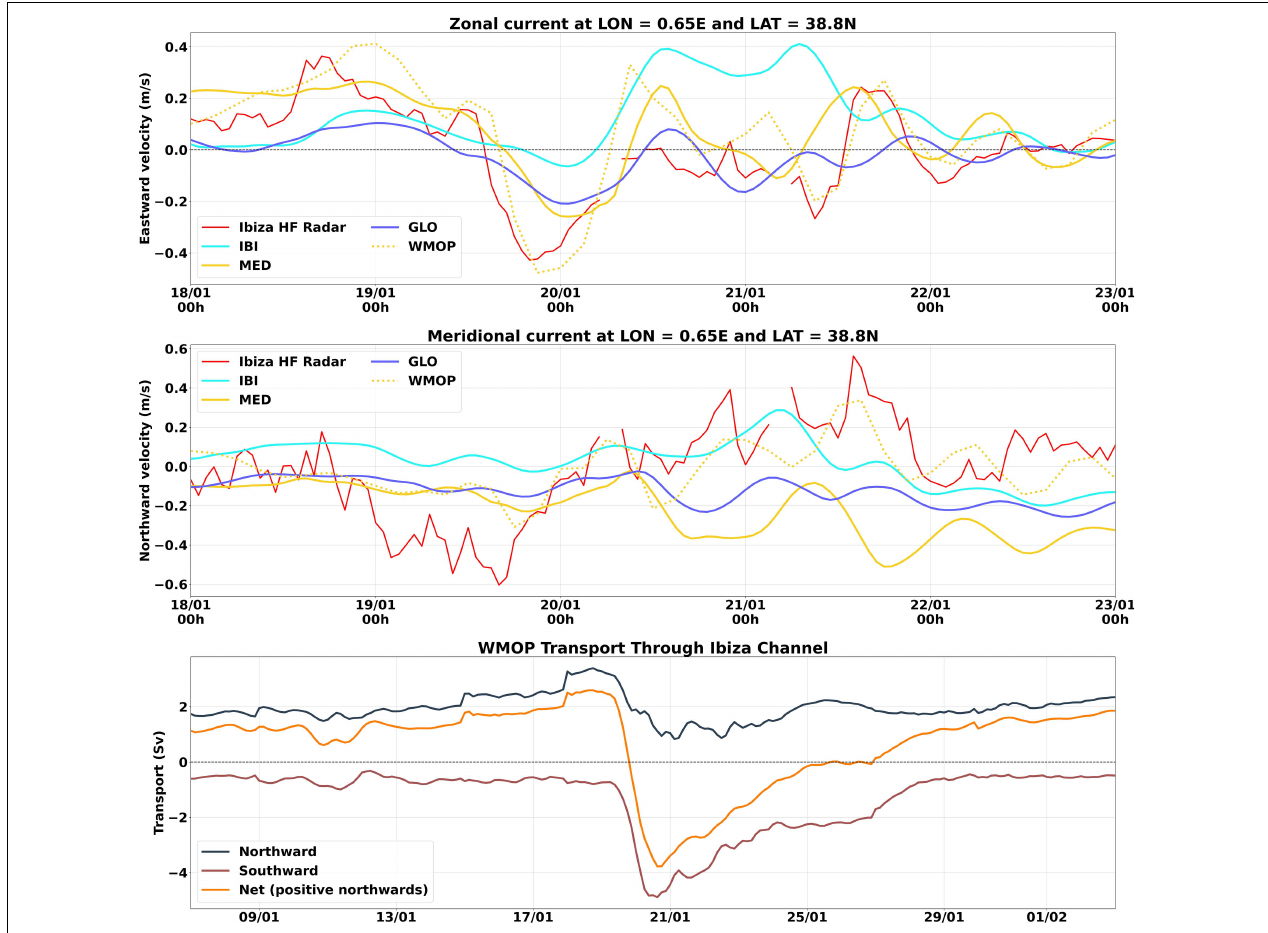
FIGURE 10 | Comparison of zonal (top panel) and meridional (middle panel) surface velocities observed by Ibiza Channel HF radar and simulated by the models for the location 0.65E–38.8N. WMOP transports through the Ibiza Channel in January 2020 (bottom